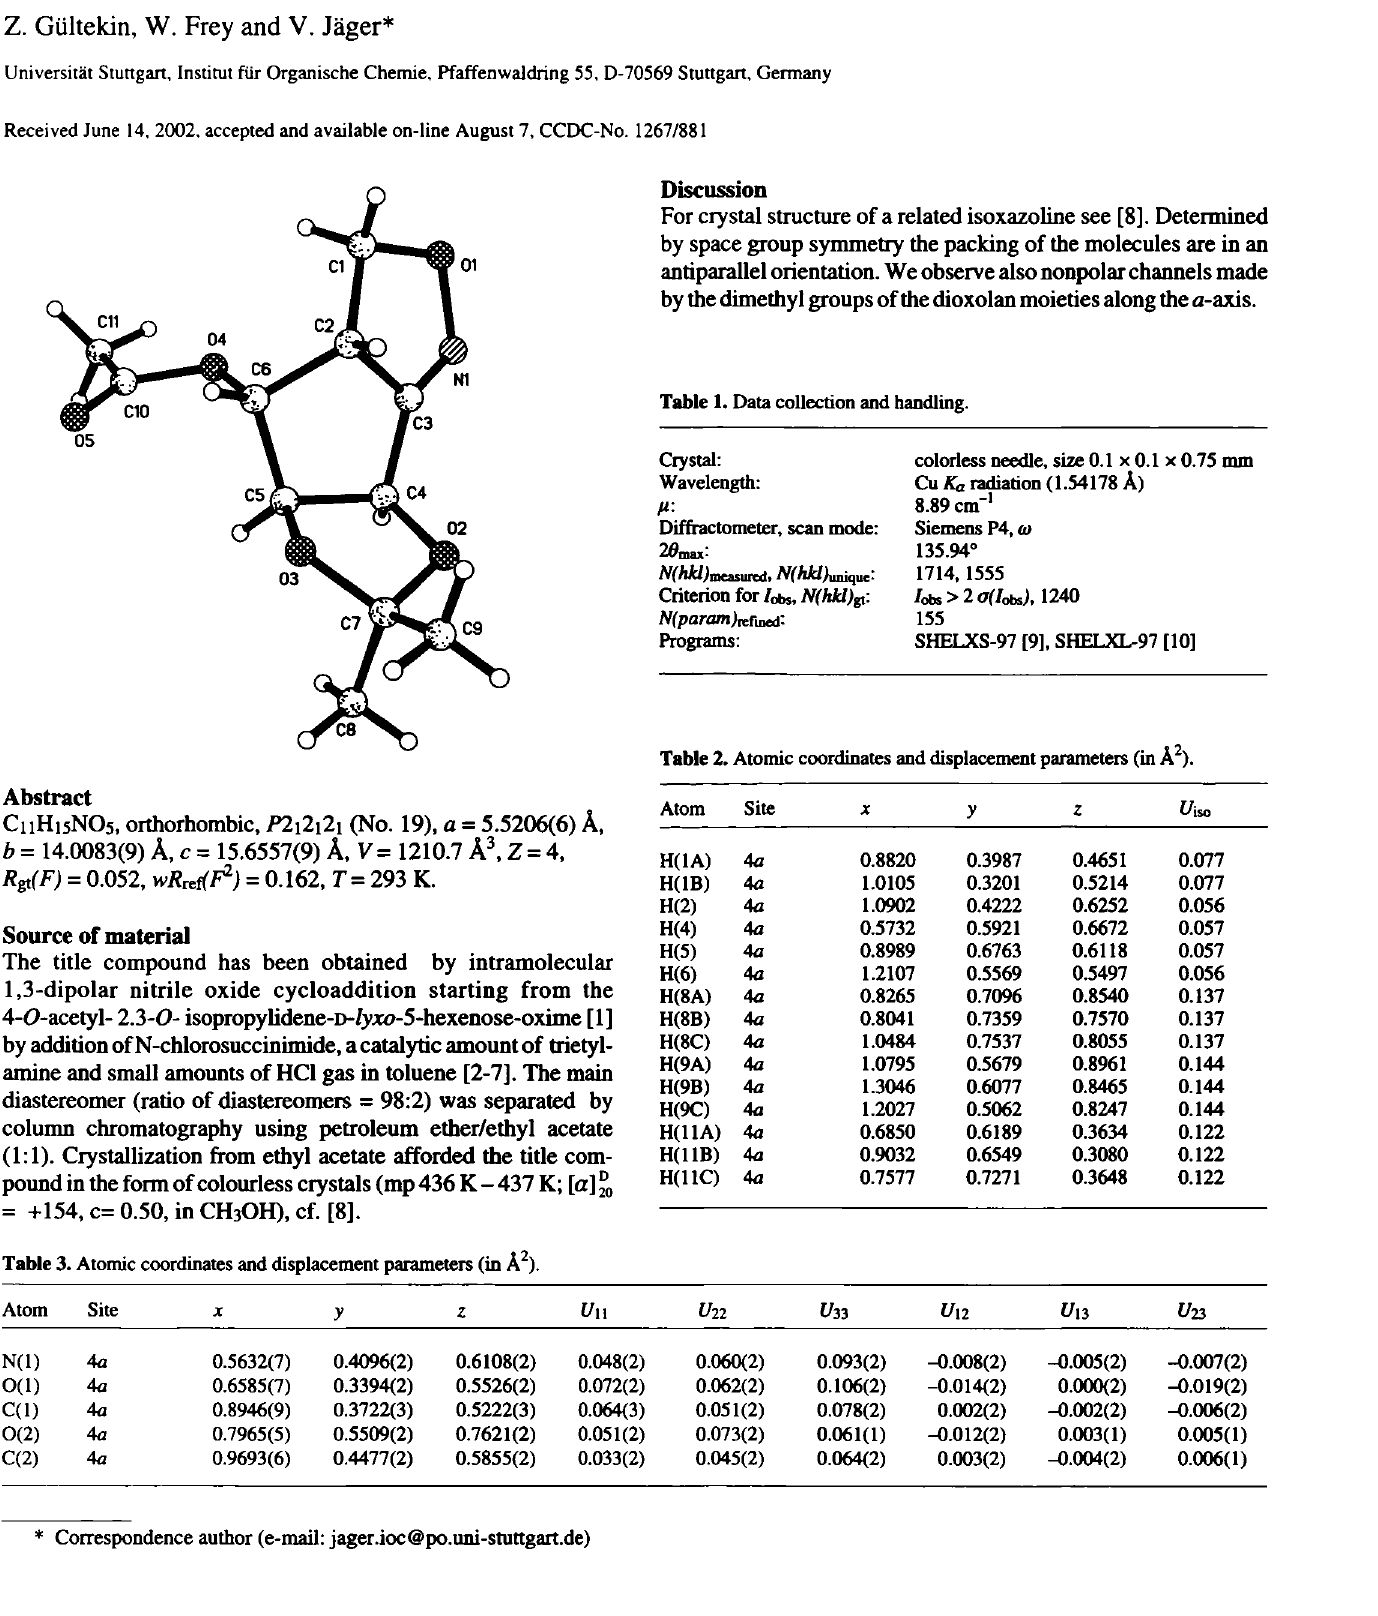
Table 1. Data collection and handling.